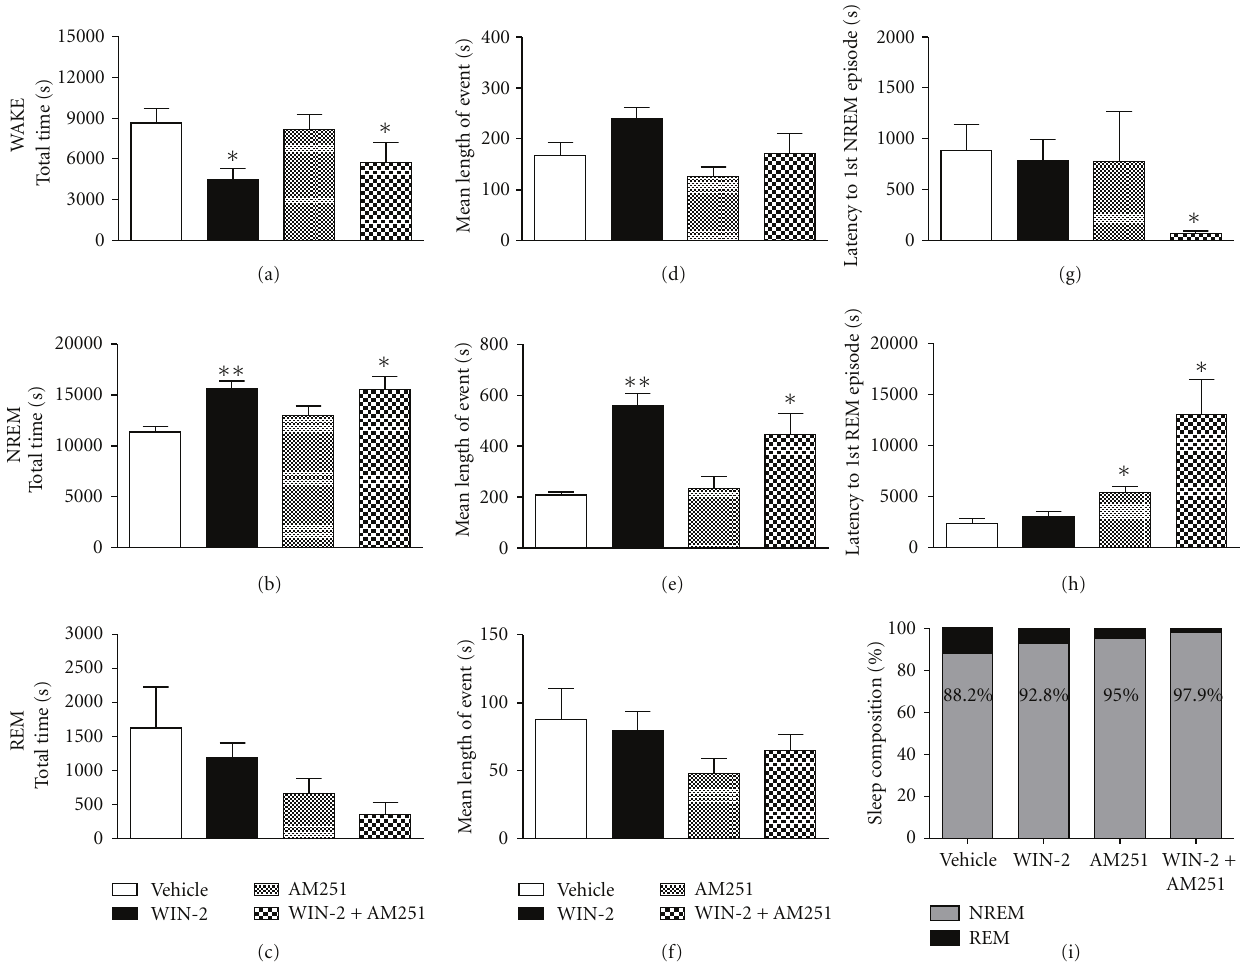
Figure 1: Total time and average length of wakefulness (a, d); NREM (b, e) and REM (c, f) episodes following systemic injections (i.p.) of vehicle (control), WIN-2 (1mg/kg), AM251 (2mg/kg), WIN-2 (1mg/kg) + AM251 (2mg/kg). WIN-2 significantly increased the time spent in NREM sleep whilst decreasing wakefulness; this was not reversed by AM251. Coadministration of WIN-2 and AM251 reduced the latency to the 1st NREM event (g) whilst AM251 either alone or in combination with WIN-2 increased the latency to the 1st REM (h) episode in comparison to controls. The overall sleep composition (% of NREM versus REM) following each respective treatment is depicted in (i). All data (mean ± SEM) were pooled over a 6h recording period in the light phase. ∗ P < 0 . 05; ∗∗ P < 0 . 01 for paired comparison relative to vehicle